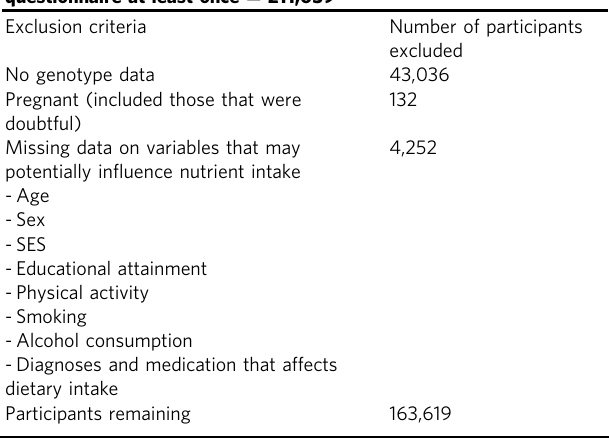
Table 2 Exclusion of UK Biobank